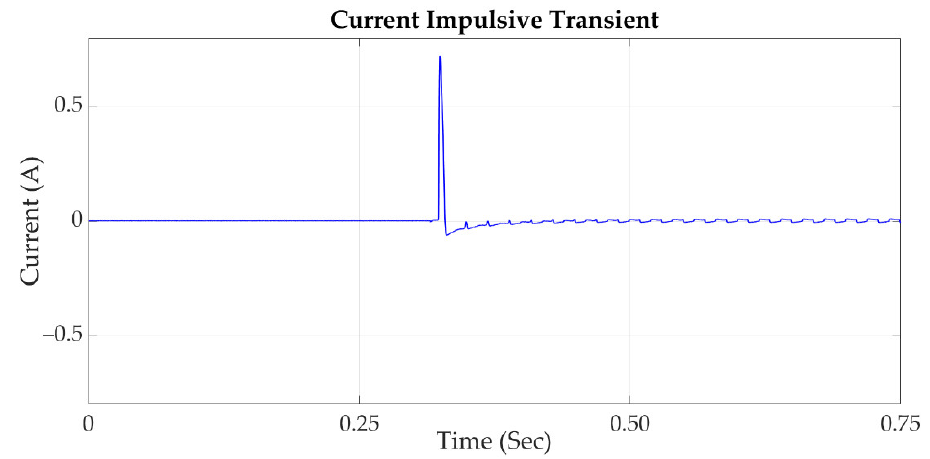
Figure 1. Current signal which contains an impulsive transient.